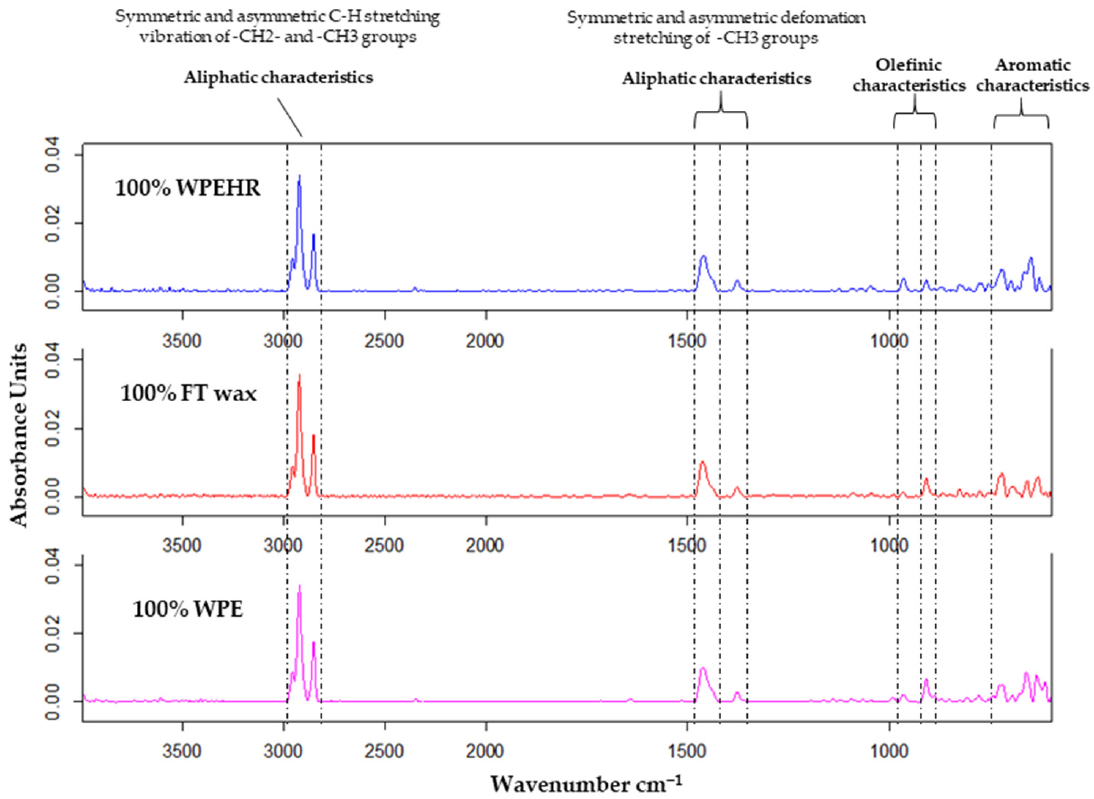
Figure 6. FTIR spectra of thermo-catalytic pyrolysis (catalyst in the 2nd reactor).